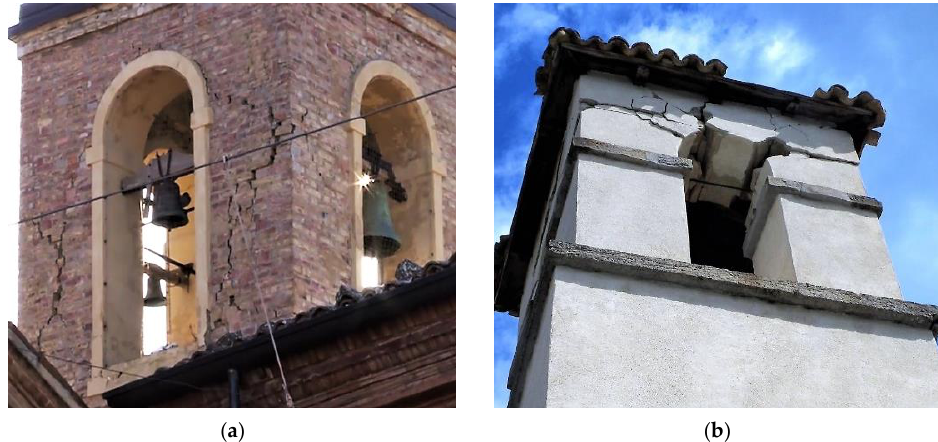
Figure 19. The structural component of the bell cell: ( a ) the case of St. Savino church in Gualdo (C36); ( b ) the case St. Maxim Oratory in Collalto, Amatrice (C8).